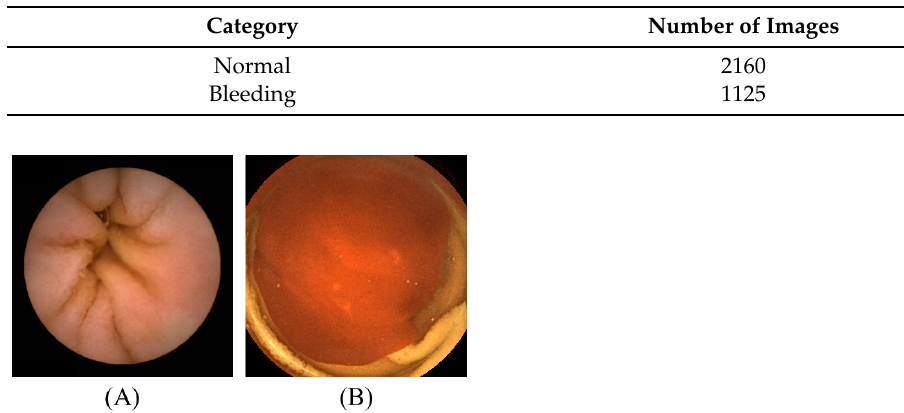
Table A2. Data distribution of RLE dataset [28].